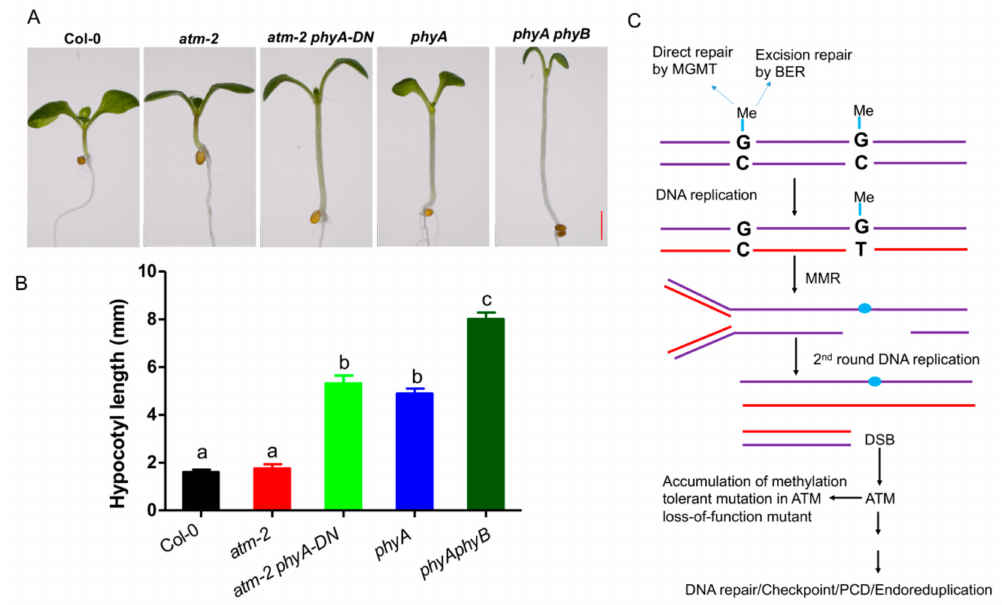
Figure 4. ATM loss-of-function mutants can be used to produce genetic materials in Arabidopsis . ( A ) Identification of a dominant negative (DN) mutant phyA-DN in EMS-treated atm mutant. After sowing, the petri dish with the seeds is placed at 4 ◦ C for 3 days, and cultivated in a greenhouse at 22 ◦ C for 5 days (18 L / 6 D). ( B ) Measurement of hypocotyl length of the indicated seedlings. Di ff erent letters represent significant di ff erences (two-way ANOVA and post-hoc Tukey test, p < 0.05). ( C ) Schematic representation of usage of atm for generating genetic